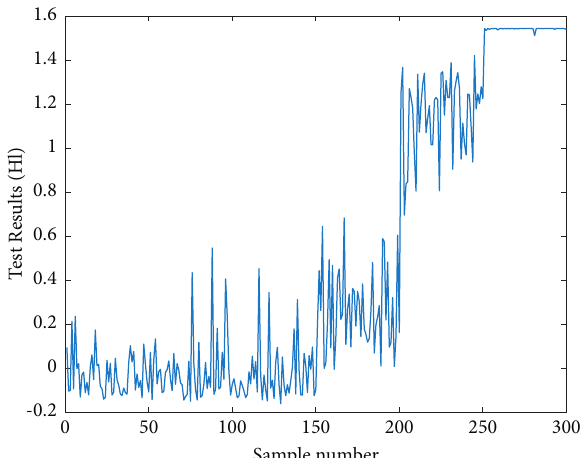
Figure 13: Evaluation chart of feature extraction through orthogonal wavelet transformation.